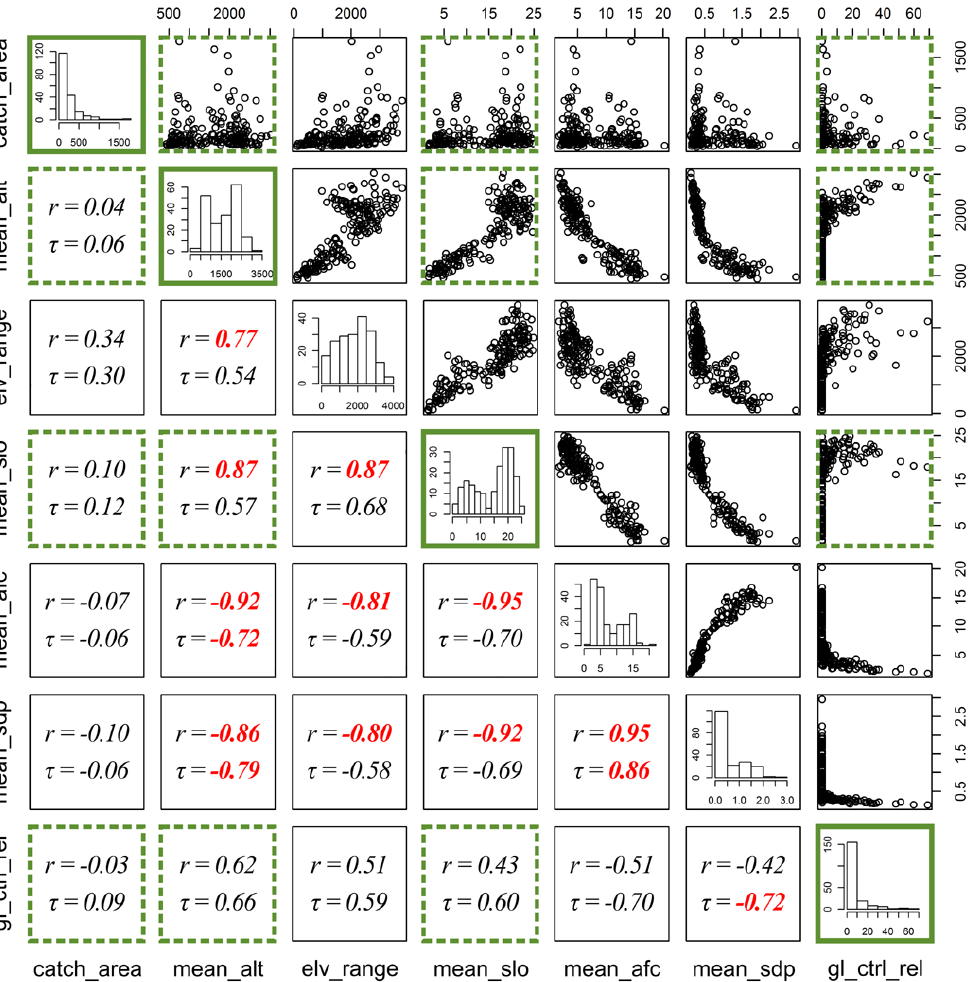
Fig. 2. Correlation analysis of physiographic catchment properties (for abbreviations see Table 1). For each pair of variables, a scatter plot (upper right part of the figure) and Pearson’s correlation coefficient ( r ) as well as Kendall’s tau ( τ ) are given (lower left part of the figure). Red values indicate high correlations ( > 0.7). In between, the histogram of each variable is displayed to visualize its distribution. The variables whose histograms are marked with a green box are used in further